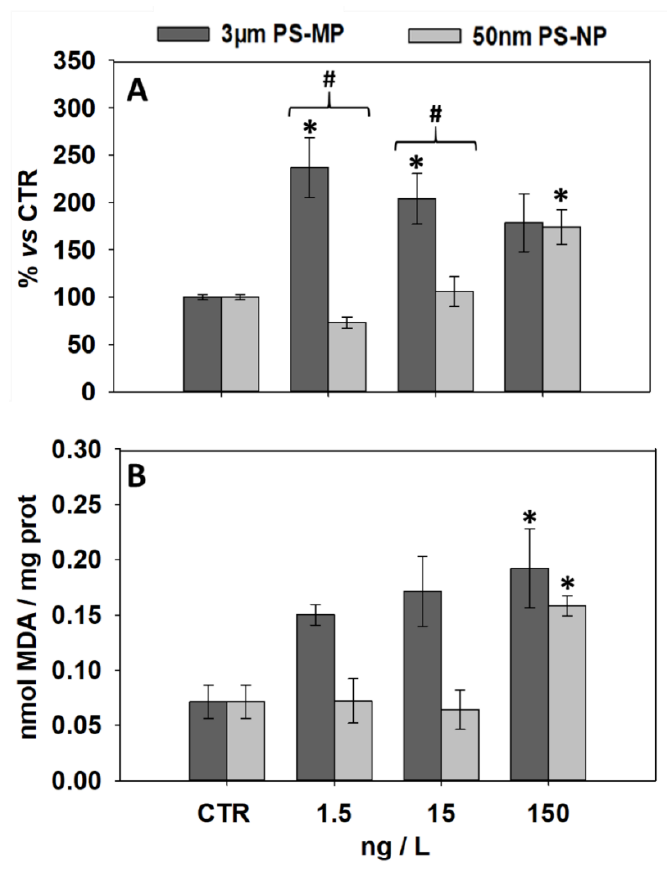
Figure 2. Lipid peroxidation parameters (mean ± SEM, N = 3) analyzed in mussels after 21 days of exposure to PS-MP and PS-NP; ( A ), intra-lysosomal content of lipofuscin (LF) content in the digestive gland; ( B ), malondialdehyde (MDA) content in the digestive gland. *, significant ( p < 0.05) differences compared to control samples (CTR); #, significant differences ( p < 0.05) between PS-MP and PS-NP treatments.